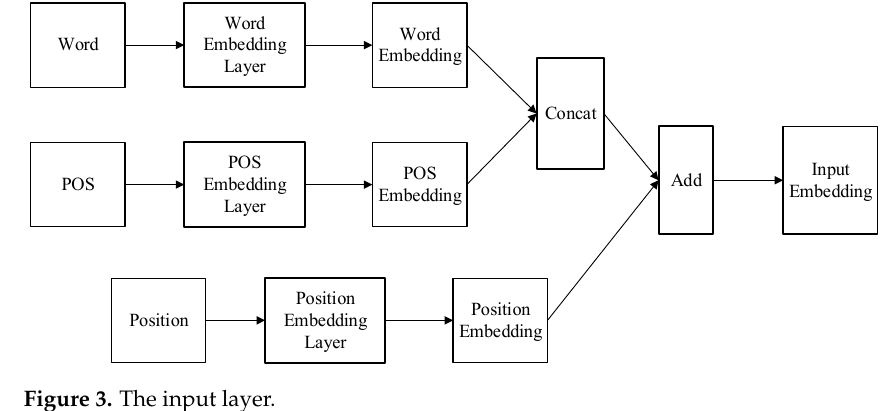
Figure 3. The input layer.